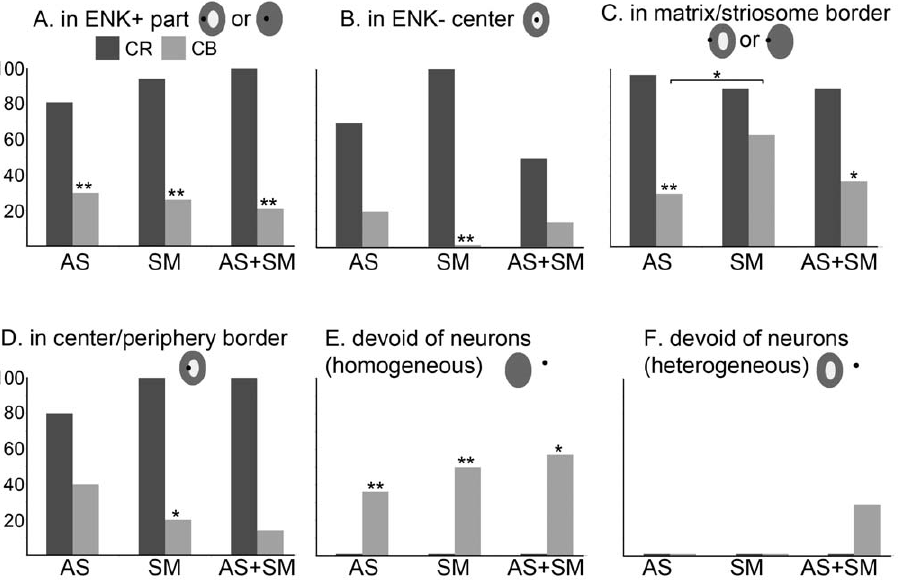
Figure 5. Compartmental organization of the CR- and CB-ir interneurons with respect to the ENK-ir striosomes. Bar graphs showing the percentage of sampled striosomes (Y axis) that contained CR or CB interneurons in the associative (AS), sensorimotor (SM) and associative + sensorimotor overlapped (AS + SM) territories. Each graph refers to the percentage of striosomes that contained interneurons in the mentioned locations, namely: in the dark ENK-ir striosomal aspect (A), in the light ENK-ir striosomal center (B), in the matrix/striosome border (C), in the center/periphery border (D), devoid of cells (striosomes with a homogeneous ENK + labeling, E), devoid of cells (striosomes with visible center and periphery, F). A total of 58 (for CR; 42 homogeneous, 16 heterogeneous) and 70 (for CB; 53 homogeneous, 17 heterogeneous) striosomes were selected among all the human brains included in the study. Please note that locations A and C include both homogeneous and heterogeneous striosomes. Asterisks show significant (*, 0.05 . P . 0.01) or highly significant (**, P , 0.01) differences between CR and CB interneurons after Fisher’s exact test. The only statistical difference between territories within a neuronal group is shown in C (associative vs sensorimotor for CB interneurons).